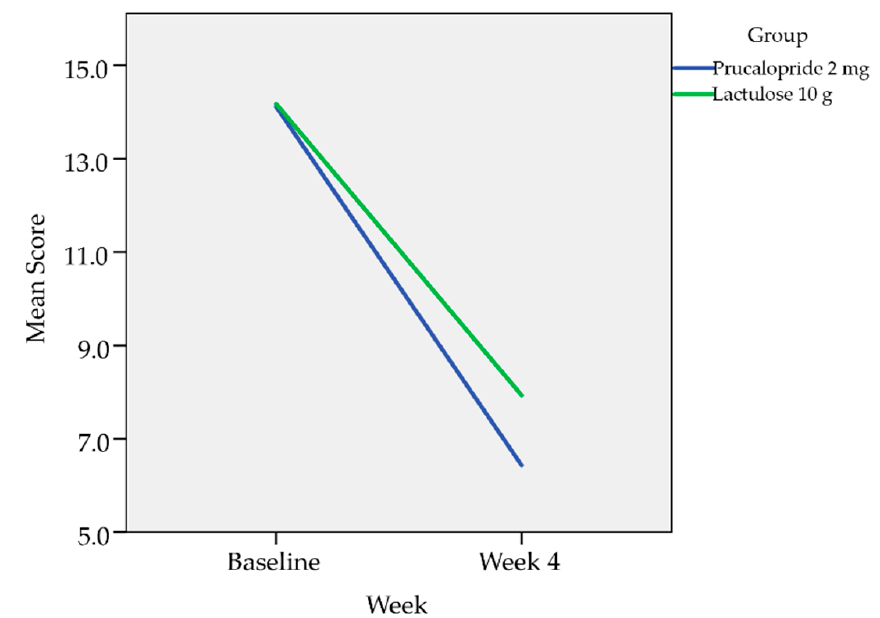
Figure 4. Repeated measure ANOVA comparing the treatment satisfaction subscale (subscale 4) from baseline to Week 4.